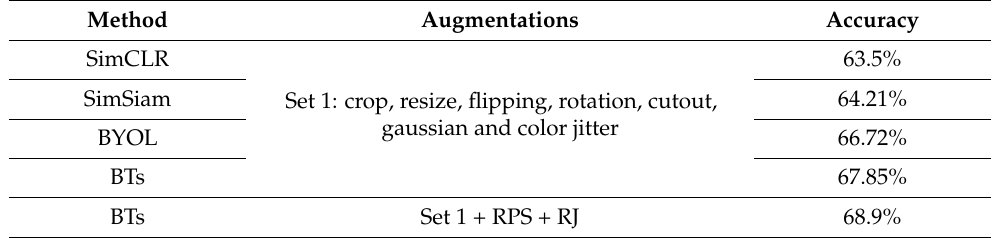
Table 1. Comparisons of SSL methods.